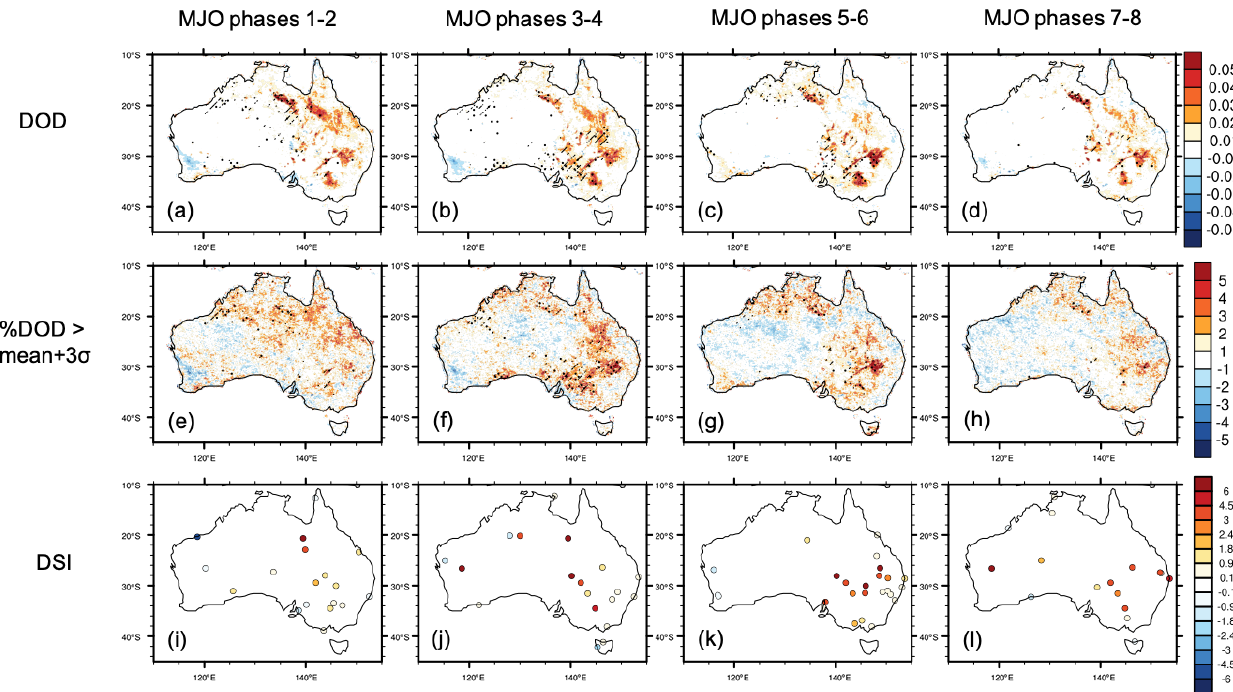
Figure 13. Regression of anomalies in dust activity during each consecutive two MJO phases in September–February upon the antecedent June–August (JJA) Niño 3.4 by MJO phase. Analyzed dust variables include (a–d) DOD averaged from MODIS-Terra and MODIS-Aqua, (e– h) frequency of daily DOD anomaly exceeding 3 times the interannual standard deviation, and (i–l) DSI. The anomalies for each consecutive two MJO phases, namely phases 1–2, 3–4, 5–6, and 7–8, are calculated as the differences between these two phases and the long-term average during September–February of 2003–2019. In (a–h) , the stitches indicate regions with significant regression coefficient ( p < 0 . 05), based on the Monte Carlo bootstrap test for the null hypothesis of a phase-invariant regression coefficient, and the slashes further denote regions with significant positive correlation between MODIS DOD and MISR nsAOD. In (i–l) , only statistically significant regression coefficients ( p < 0 . 05) are